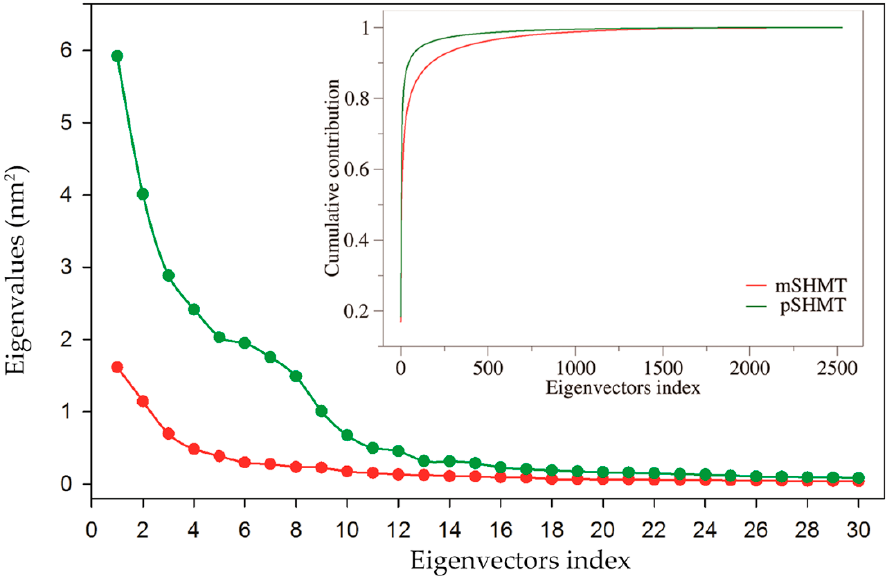
Figure 4. Eigenvalues of the first 30 eigenvectors (main plot) and cumulative contribution of all eigenvectors to the total mean square fluctuations (inset plot) obtained from essential dynamics analyses of the single joined equilibrium MD trajectories of mSHMT (red line) and pSHMT (green line).